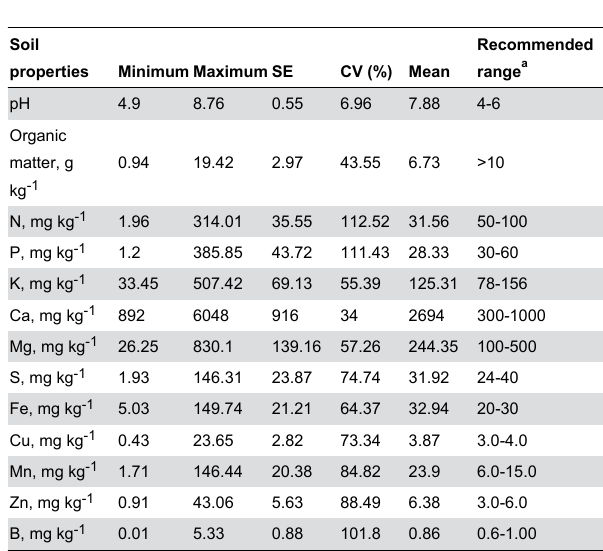
Table 3. Descriptive statistics of soil properties from the 0– 20 cm layer in nine cities in Hubei province (n = 405).